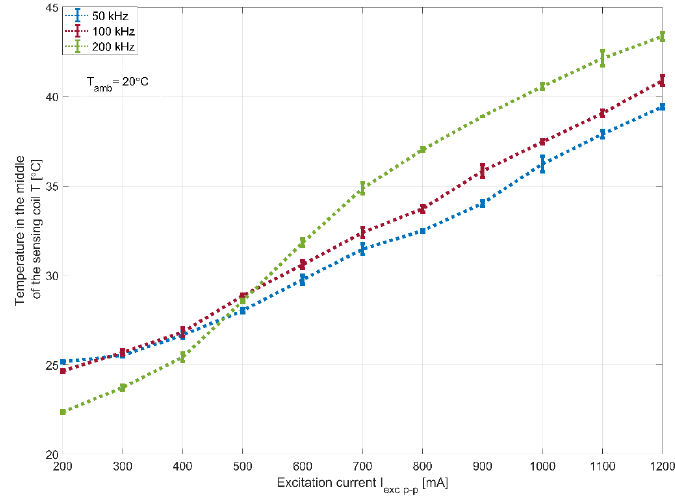
Figure 8. Measured temperature at the centre of the magnetic core as a function of the excitation